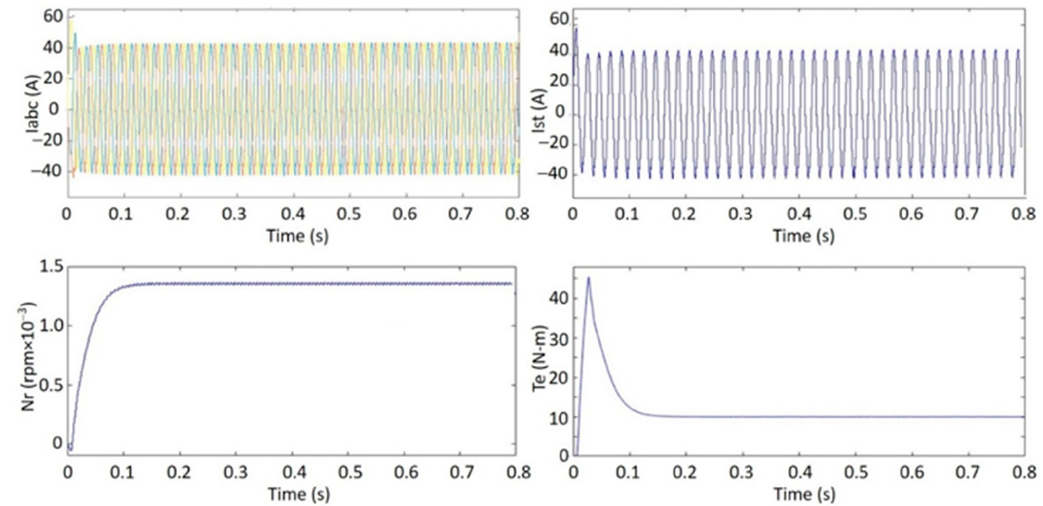
Figure 7. Simulation results under healthy conditions.